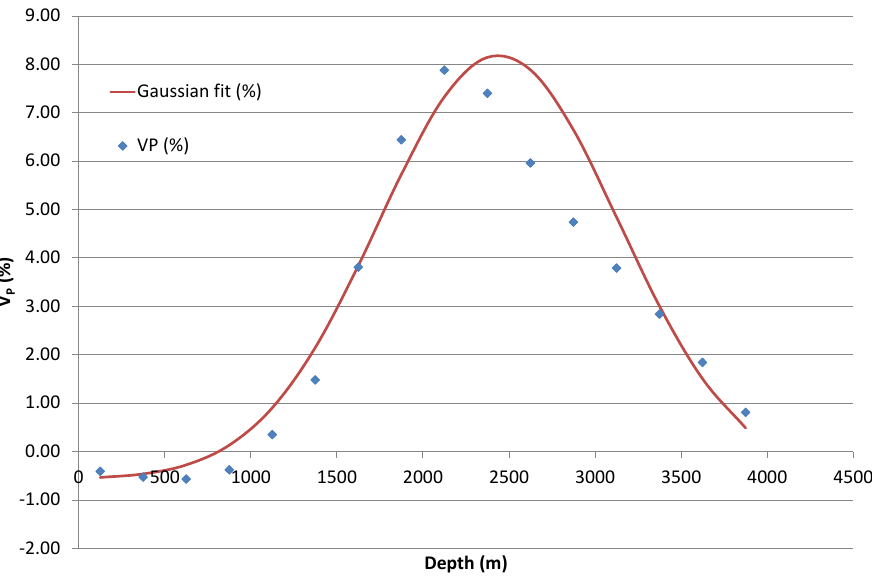
Figure 10. Fit of seismic anomaly data to an offset Gaussian function. The equation constants are Δ = −0.57, k = 8.76, μ =10.26, σ = 3.95, the rms error is 0.80 (see appendix for details). A perfect fit is not necessary. The purpose of the fitting is simply to gauge general location 4500 m·E and 8750 m·N in the